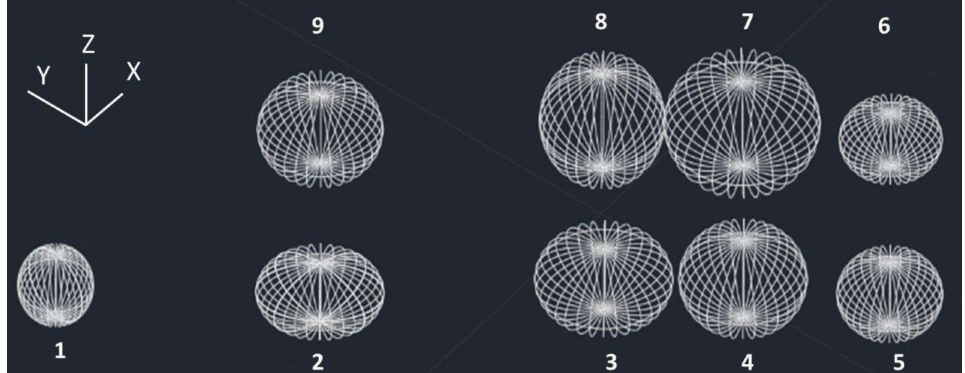
Figure 6. Results displaying the traditional method (TM). The numbers mean the tree number for Table